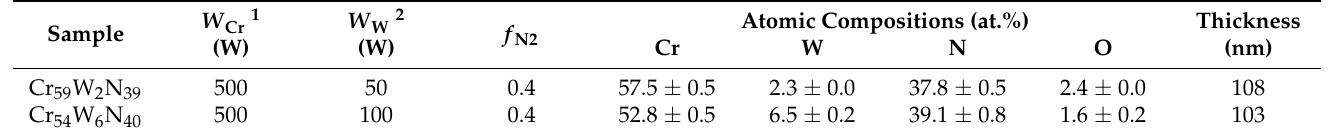
Table 2. Co-sputtering parameters, atomic compositions, and thicknesses of CrWN films.